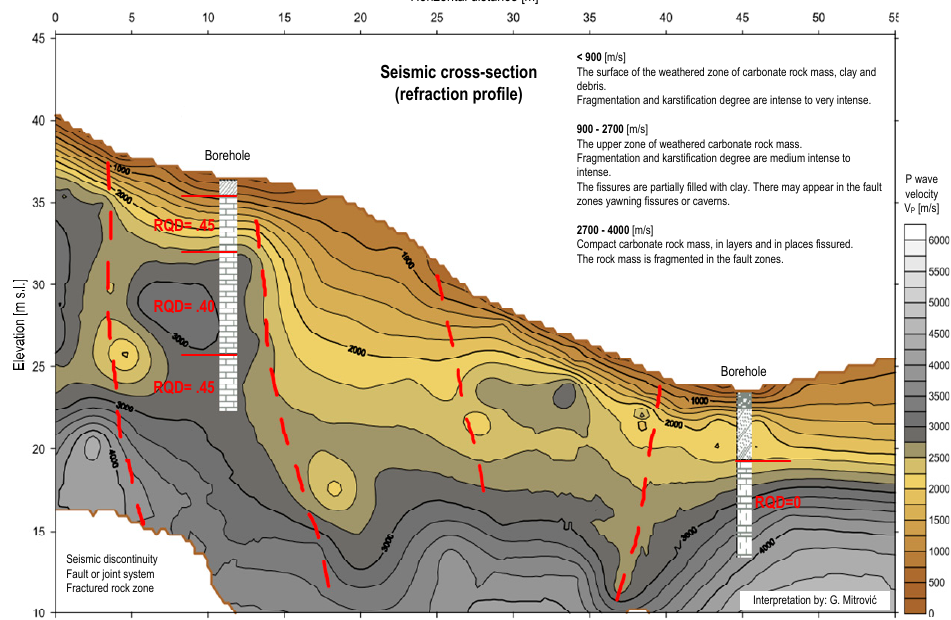
Figure 7. Original geophysical-geological interpretation of seismic profile for foundation design of a shopping mall in Rijeka, from [46].